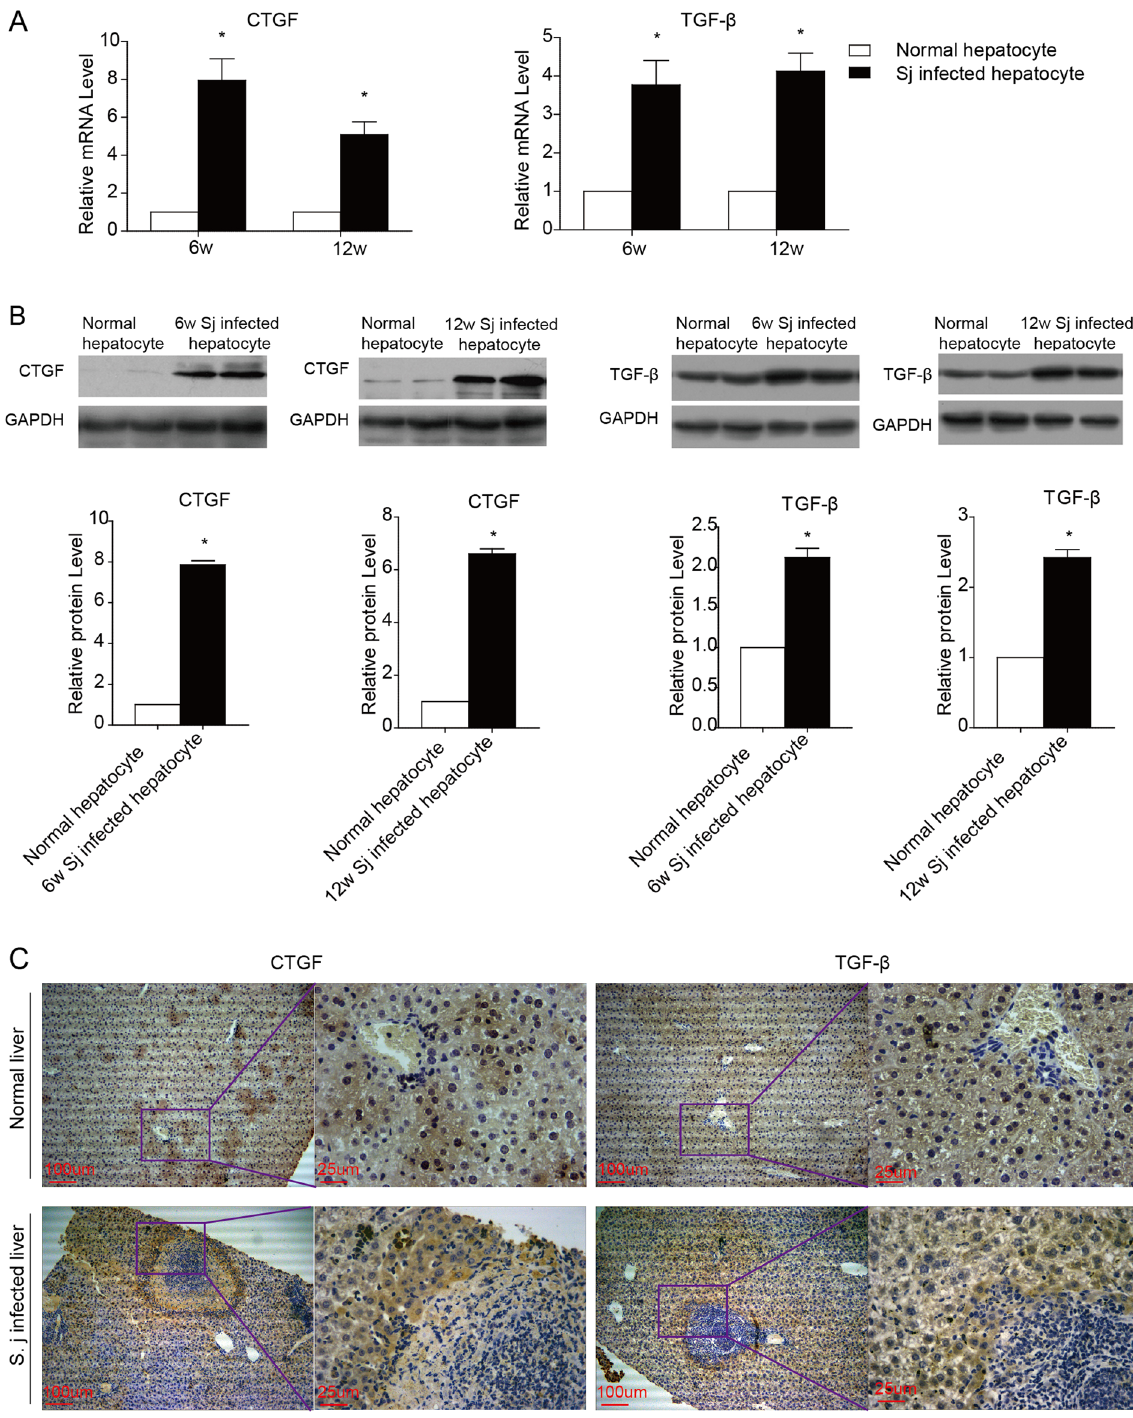
Figure 2. S. japonicum infection promotes the expression of fibrotic factors in hepatocytes. ( A and B ) Real-time PCR and western blotting were used to examine the expression of CTGF and TGF- β in primary hepatocytes purified from schistosomiasis-infected livers 6 and 12 weeks after infection. ( C ) Liver sections were immunohistochemically stained for CTGF and TGF- β . Sj, S. japonicum . Scale bar, 100 μ m (left) and 25 μ m (right). Data represent the mean ± SEM; n = 5 ( * P <